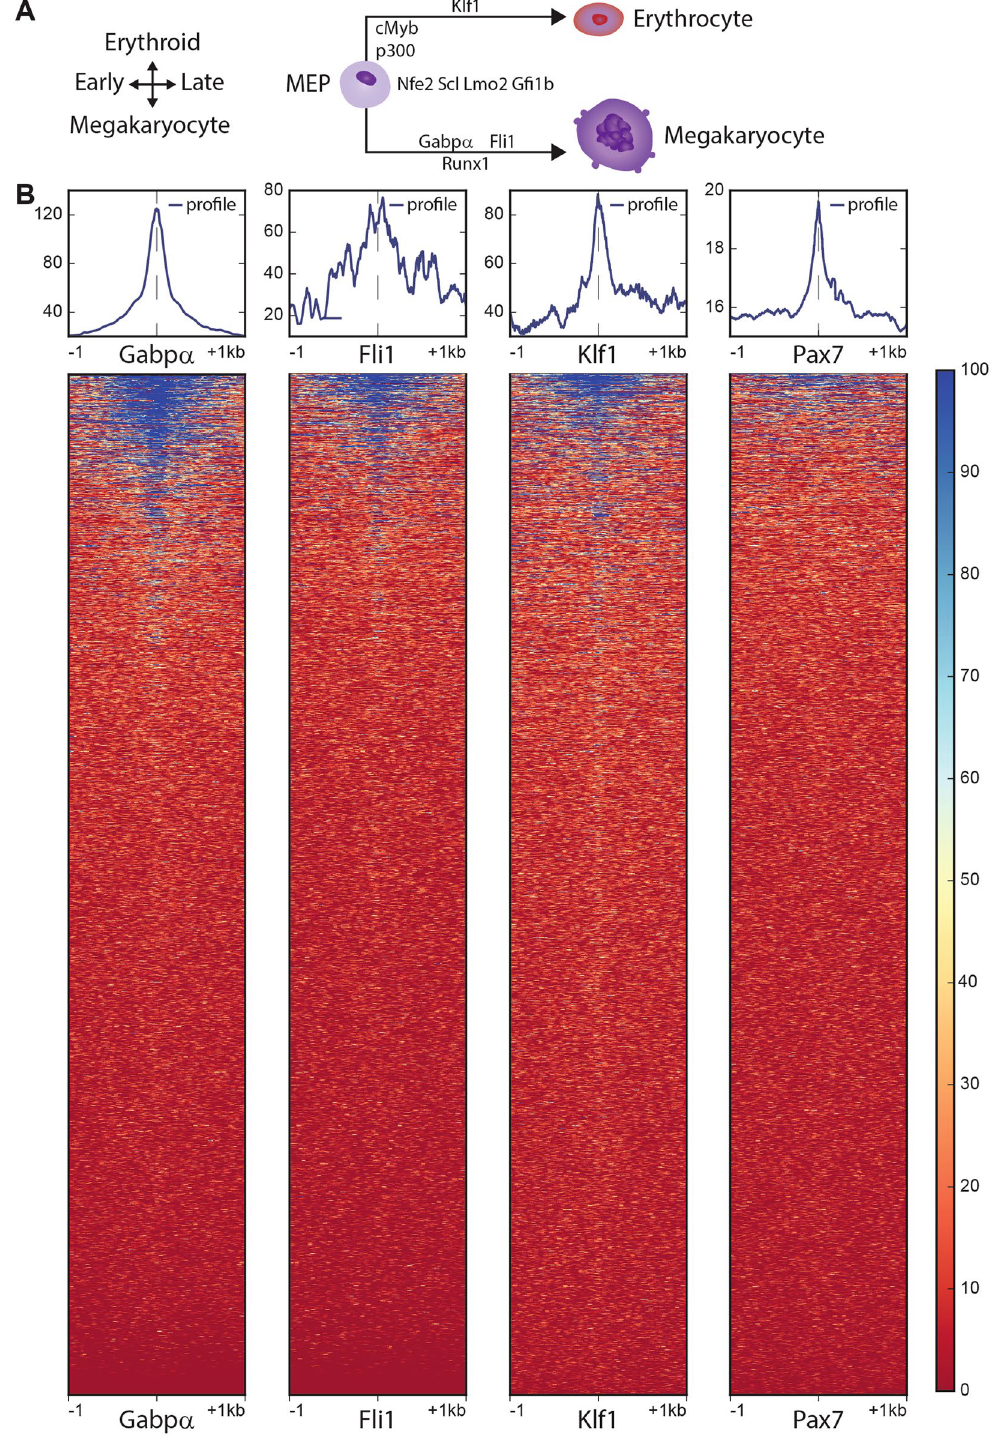
Figure 5. ( A ) Megakaryocyte differentiation, from left to right: Megakaryocyte progenitor cells (MPC) differentiate to erythrocytes (upper branch) or megakaryocytes (lower branch), while specific transcription factors for each branch drive the differentiation process (figure adapted from 10 ). ( B ) Heatmaps on four in silico predicted transcription factor binding sites in the mm10 mouse genome assembly. Binding sites are located in the center, surrounded by the ATAC read signal from − 1 kb to + 1 kb. A globally normalized color scale represents the strength of the respective ATAC signal. The binding profile is shown at the top of each heatmap. Heatmaps from the left to the right represent Gabp-alpha, Fli1and Klf1 as Megakaryocyte progenitor specific transcription factors and Pax7 as Megakaryocyte unrelated